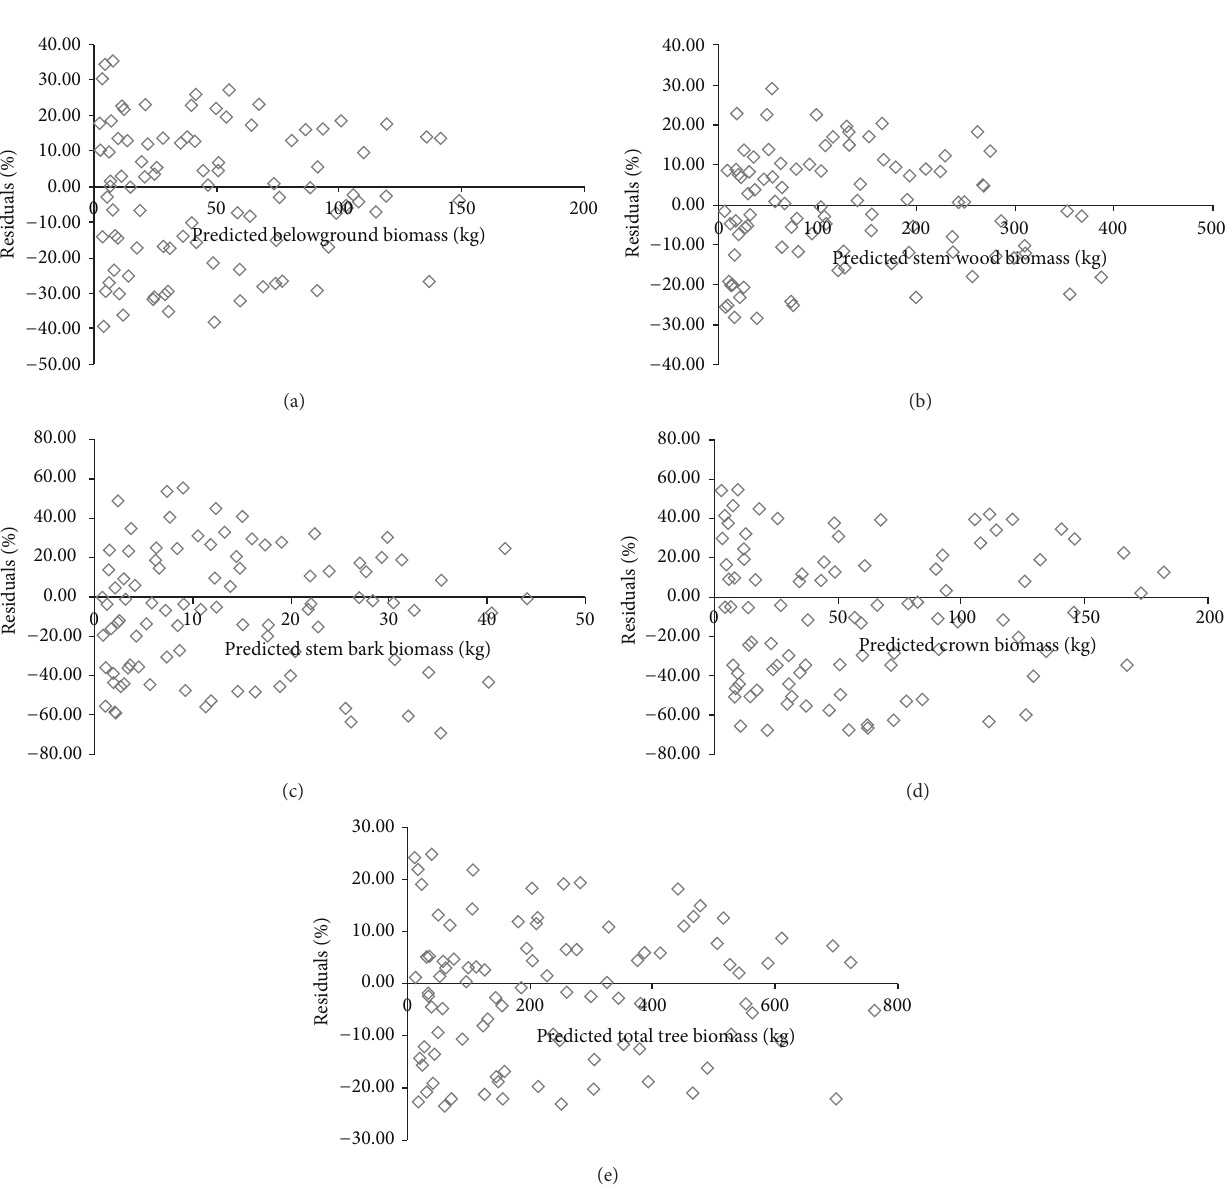
Figure 2: Residuals against predicted biomass for the CON method: (a) belowground, (b) stem wood, (c) stem bark, (d) crown, and (e) total tree